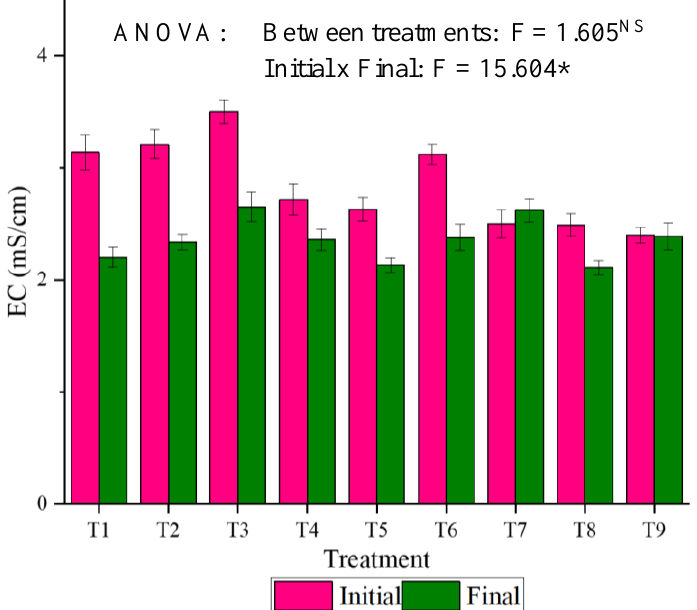
Figure 3. Dynamics of electrical conductivity among various composting treatment groups. ‘*’ indicates